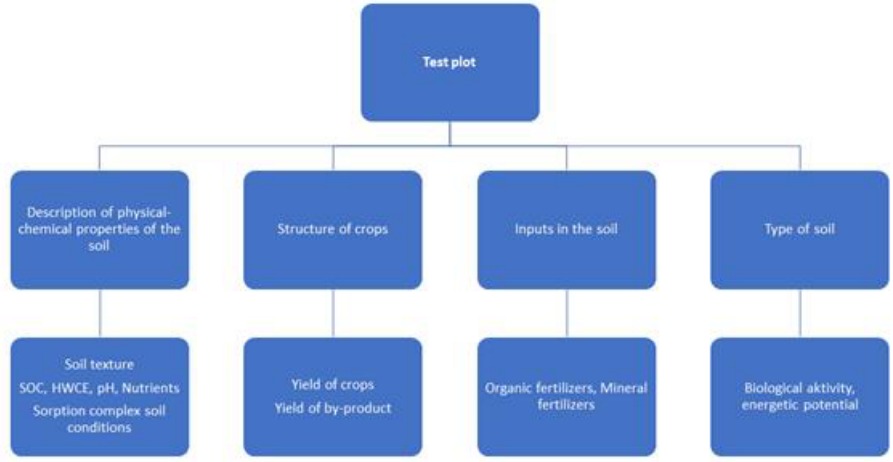
Figure A2. The basic structure monitoring. Source: MDPI